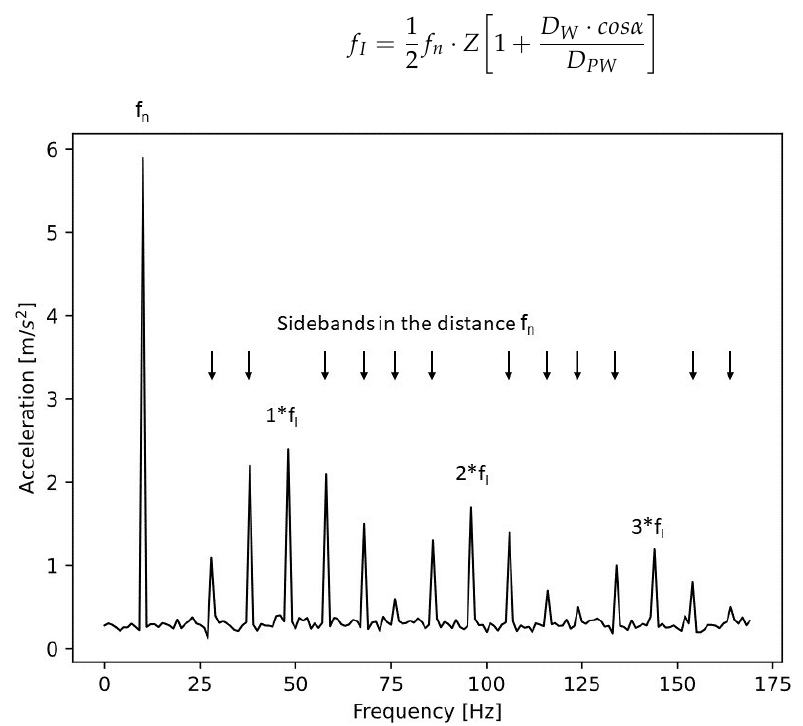
Figure 3. Envelope curve spectrum of a ball bearing with advanced inner ring